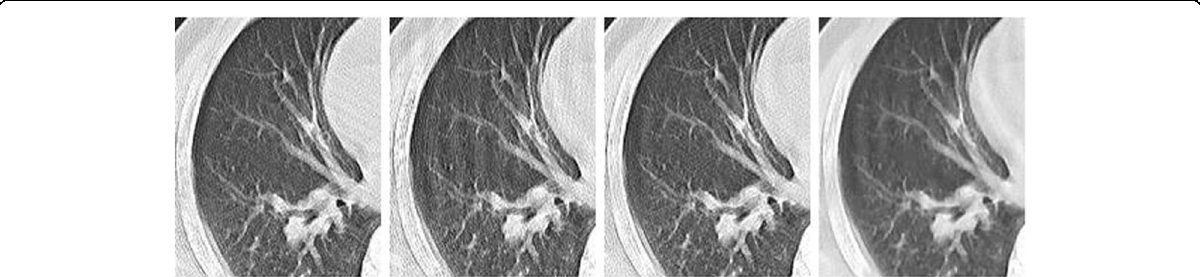
Fig. 6 Comparison of reconstructed images of local details amplification with different reconstruction methods (SNR = 40